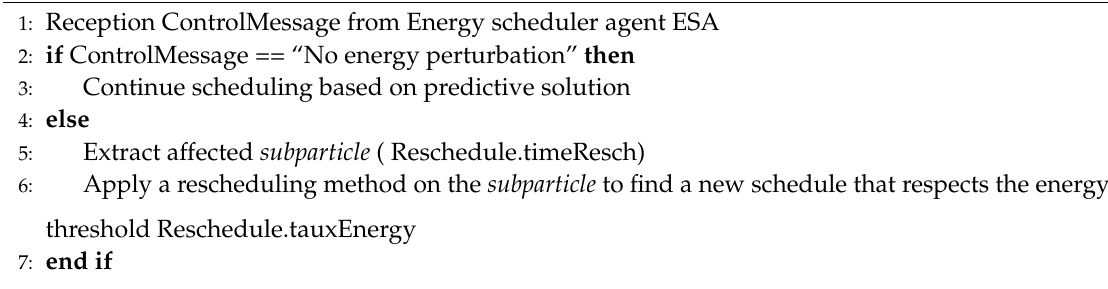
Algorithm 4 Pseudo code of external perturbation control behaviour of FSA (Period P3)